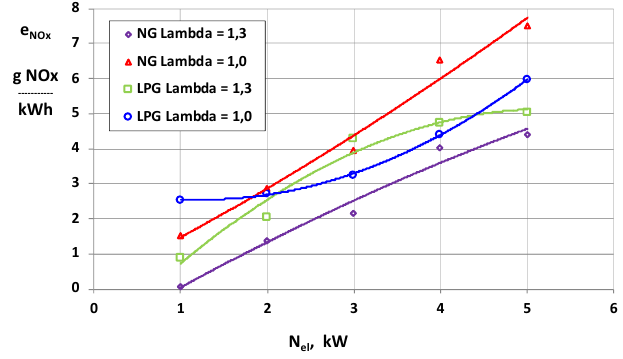
Fig. 7. Specific emission of NO x vs mCHP unit output electric power